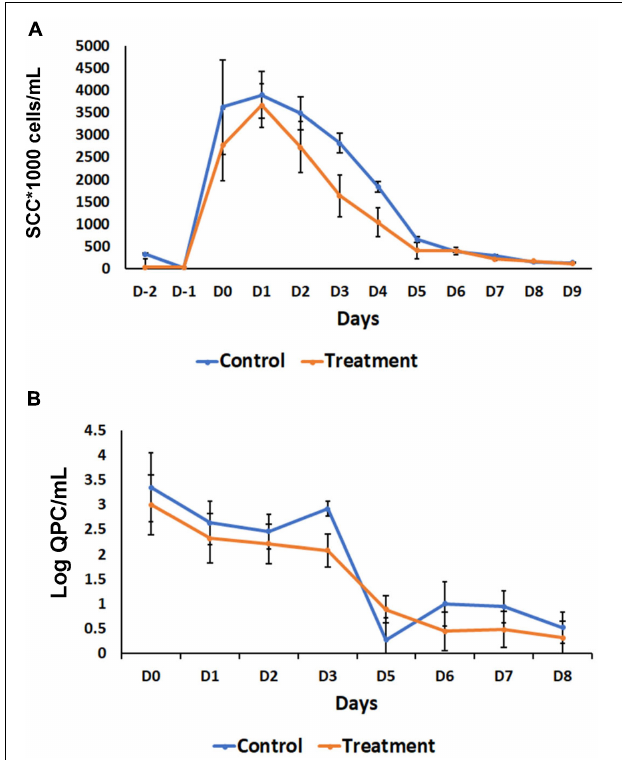
FIGURE 5 | Effect of probiotic treatment on somatic cell counts (SCC) and Staphylococcus aureus abundance. (A) SCC counts decrease after day one in B. velezensis AP183 treated group, when compared with its corresponding control, then both groups return to baseline levels after day five. (B) The relative count of S. aureus decreased steadily in treatment groups, when compared with the control. The data were expressed as mean ± standard error of log of quantitative plate counts